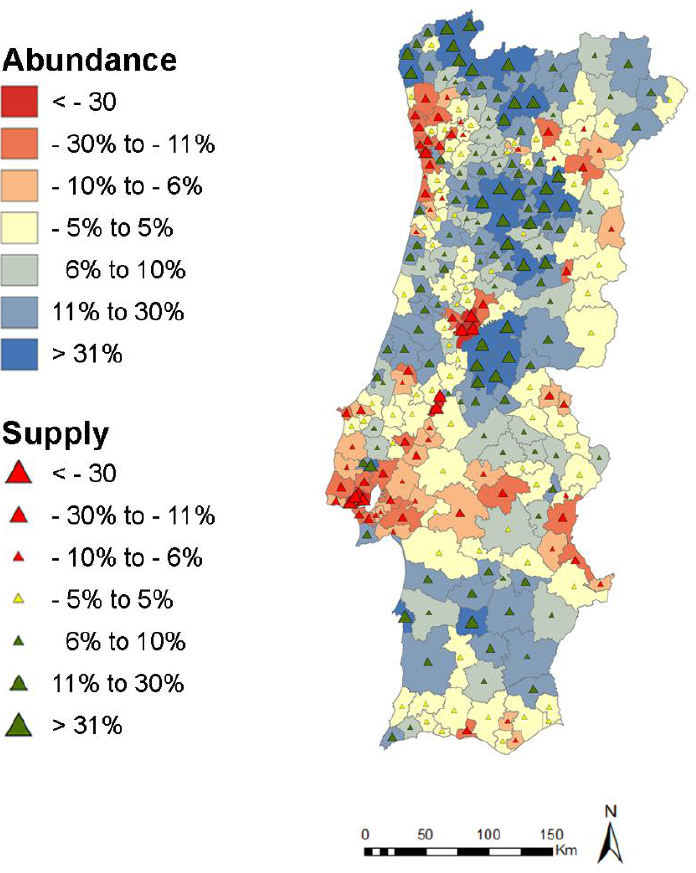
Figure 5. Percent variation (PV) from 1990 to 2018 of abundance and supply indices by municipal- ity.